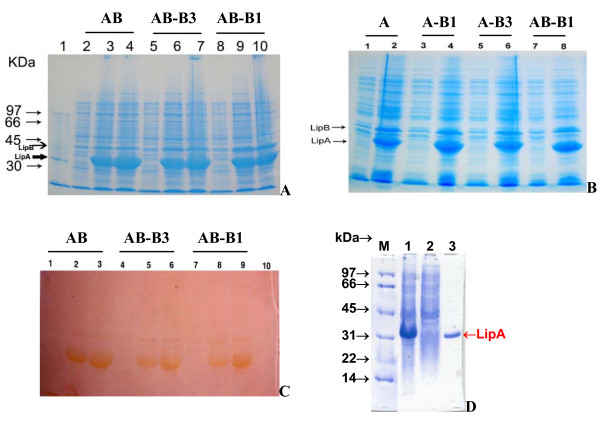
SDS-PAGE of BL21 cell lysates using dual expression cassette plasmid system. (A). pELipABa (2-4), pELipAB-LipB3a (5-7), pELipAB-LipB1a (8-10). Lanes (2, 5, 8), (3, 6, 9), (4, 7, 10) indicated induction by IPTG for 0, 2, and 4 hours, respectively; Lane 1: standard protein. (B). pELipAa (1-2), pELipA-LipB1a (3-4), pELipA-LipB3a (5-6), pELipAB-LipB1a (7-8). Odd and even lanes indicated induction by IPTG for 0 and 4 hours, respectively. (C). Lipase-activity stained SDS-PAGE of BL21 cell lysate harboring the recombinant plasmids: pELipABa (1-3), pELipAB-LipB3a (4-6), pELipAB-LipB1a (7-9). Lanes (1, 4, 7), (2, 5, 8), and (3, 6, 9) indicated induction by IPTG for 0, 2, and 4 hours, respectively. (D). pELipAB-LipB1a whole cell lysate (1), cell lysate's supernatant (2), cell lysate precipitate (3).